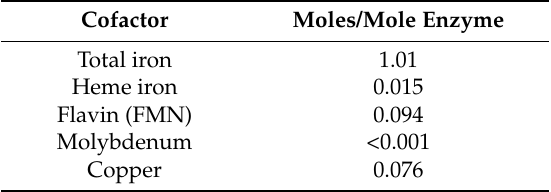
Table 1. Cofactor content of purified ketolactonase E 2 (2,5-diketocamphane 1,2-monooxygenase).